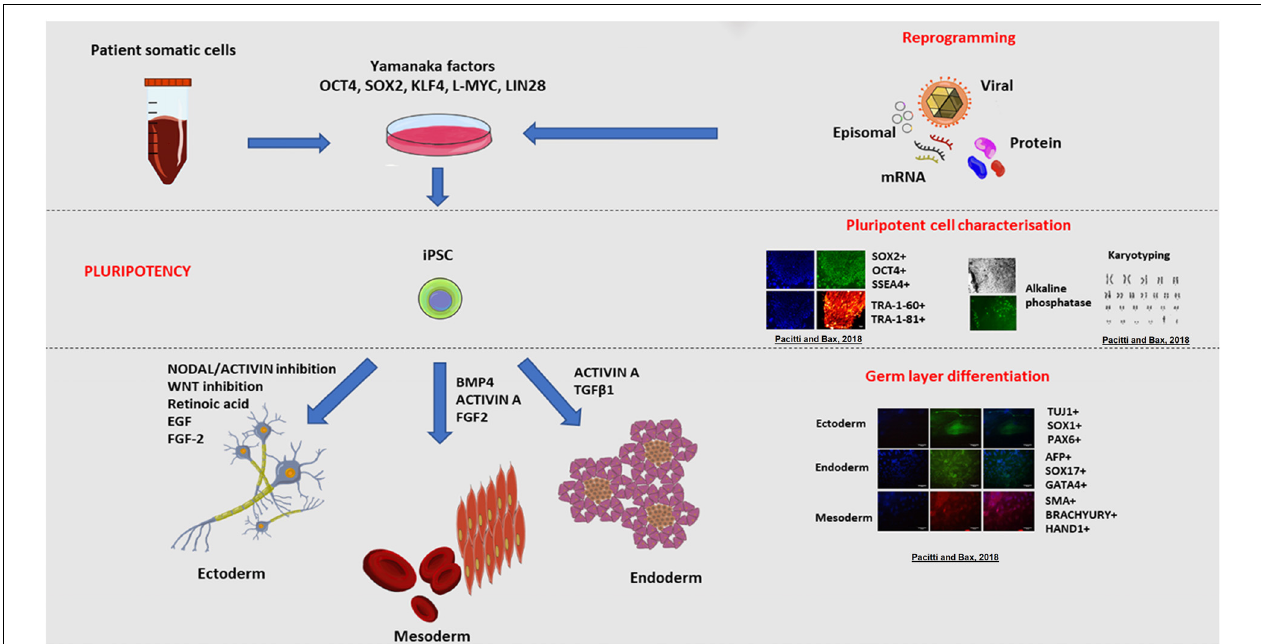
FIGURE 3 | Induced pluripotent stem cell (iPSC) derivation and characterisation. The ectopic overexpression of the transcription factors OCT3/4 , KLF4 , SOX2 , L-MYC , LIN28 , known to be expressed in ESCs, reverts mature somatic cells such as dermal fibroblasts and peripheral blood mononuclear cells (PBMC) to display a pluripotent embryonic-like phenotype (Takahashi et al., 2007; Okita et al., 2013). Transfection of cells with vectors expressing these transcription factors enables the epigenetic reprogramming of cells, through a series of stochastic events, to express endogenous OCT4 and NANOG, the characteristic transcription factors determining the pluripotency, self-renewal and proliferative capacity of cells (Lohle et al., 2012). In synergy, the ectopic overexpression of these genes triggers a sequence of epigenetic modifications leading to DNA demethylation and chromatin changes that eventually result in the acquisition of a pluripotent state in transfected cells (Jaenisch and Young, 2008). A multitude of vectors have been used to deliver the reprogramming factors and these approaches are broadly divided into non-viral and viral, and integration and non-integration methods. For instance, reprogramming could be achieved using viral vectors including retroviruses, lentiviruses and more recently Sendai non-integrating virus. Alternatively, non-viral methods include mRNA or protein delivery or transient expression achieved with episomal plasmids. Pluripotent stem cells are defined by the presence of specific markers including cell surface proteoglycans (TRA-1-60 and TRA-1-81) and glycosphingolipids (SSEA-3 and SSEA-4) and the expression of transcription factors OCT4 and SOX2 (Thomson et al., 1998; Tonge et al., 2011). The resulting pluripotent cells, have the same embryonic plasticity for differentiating into almost any tissue type of the three germ layers (endoderm, mesoderm and ectoderm) when stimulated by the appropriate signalling molecules and growth factors (Itskovitz-Eldor et al., 2000; Okita et al., 2013). Examples of cells derived from the germ layers include nervous and epidermal tissue from the ectoderm, haematopoietic and muscle cells from the mesoderm, and pancreatic cells from the endoderm. Copyright permission was obtained for the reproduction of images taken from Pacitti and Bax